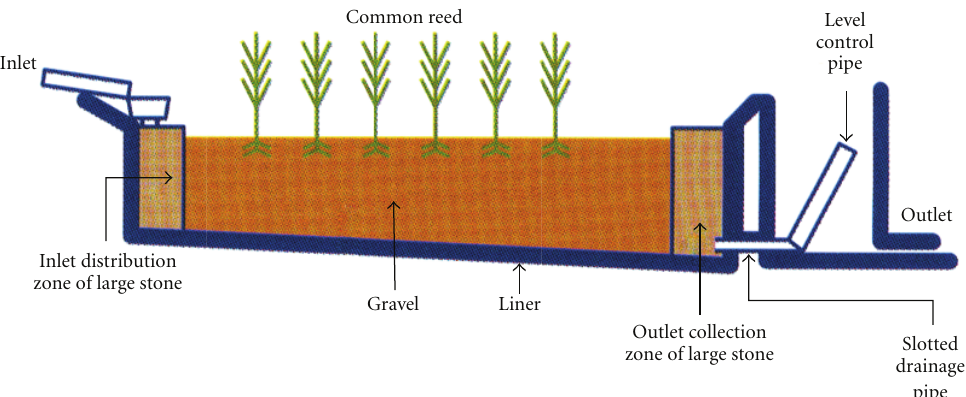
Figure 2: Simplified layout of a tertiary treatment reed-bed shown is the simplified layout of a tertiary treatment reed-bed, where wastewater enters at the inlet, is cleaned in the reed-bed area through filtration and absorption of nutrients by the reeds, and released at the outlet into rivers and streams, hence the location of the reed-bed alongside flowing water. Source is Severn Trent Water [11].